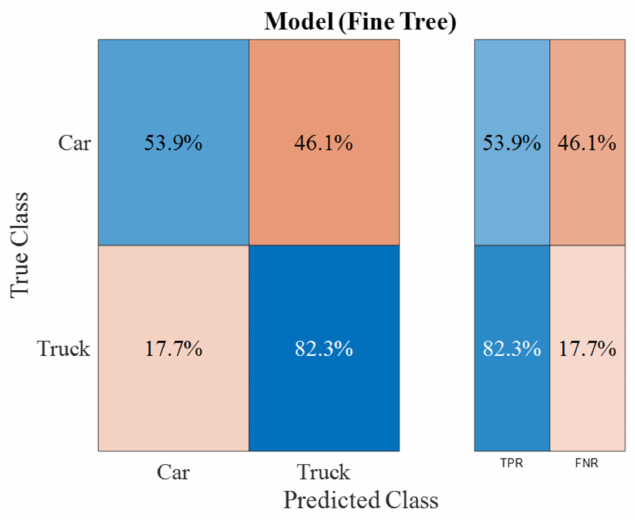
Figure A3. Confusion matrix TRP for linear